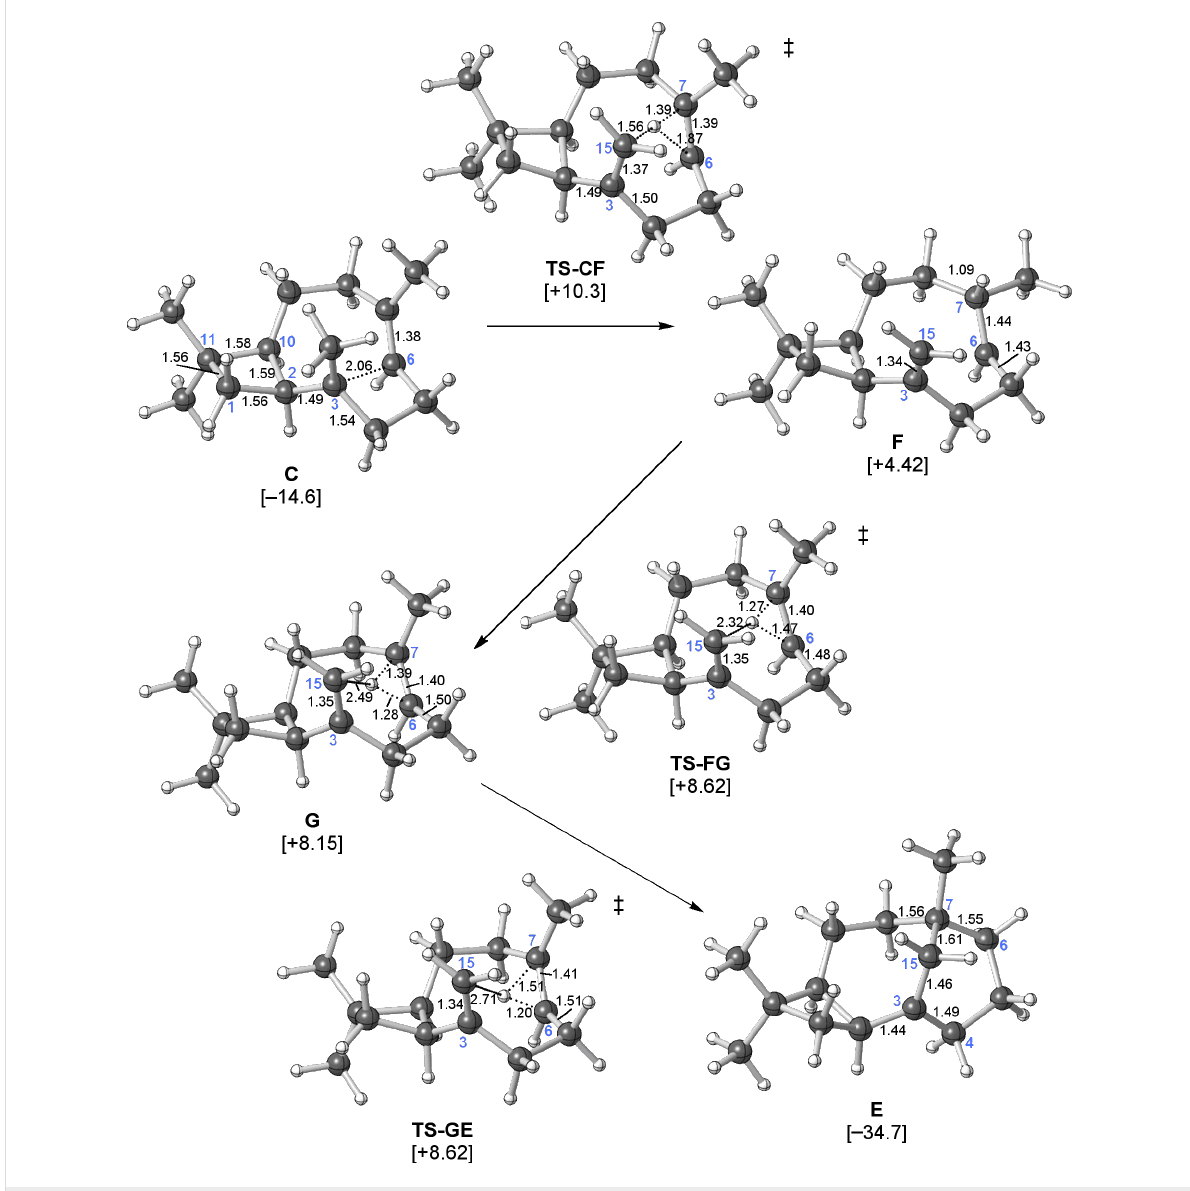
Figure 5: Computed pathway for the conversion of C to E . Relative energies shown (kcal/mol) were calculated at the mPW1PW91/6-31+G(d,p)// B3LYP/6-31+G(d,p) level.